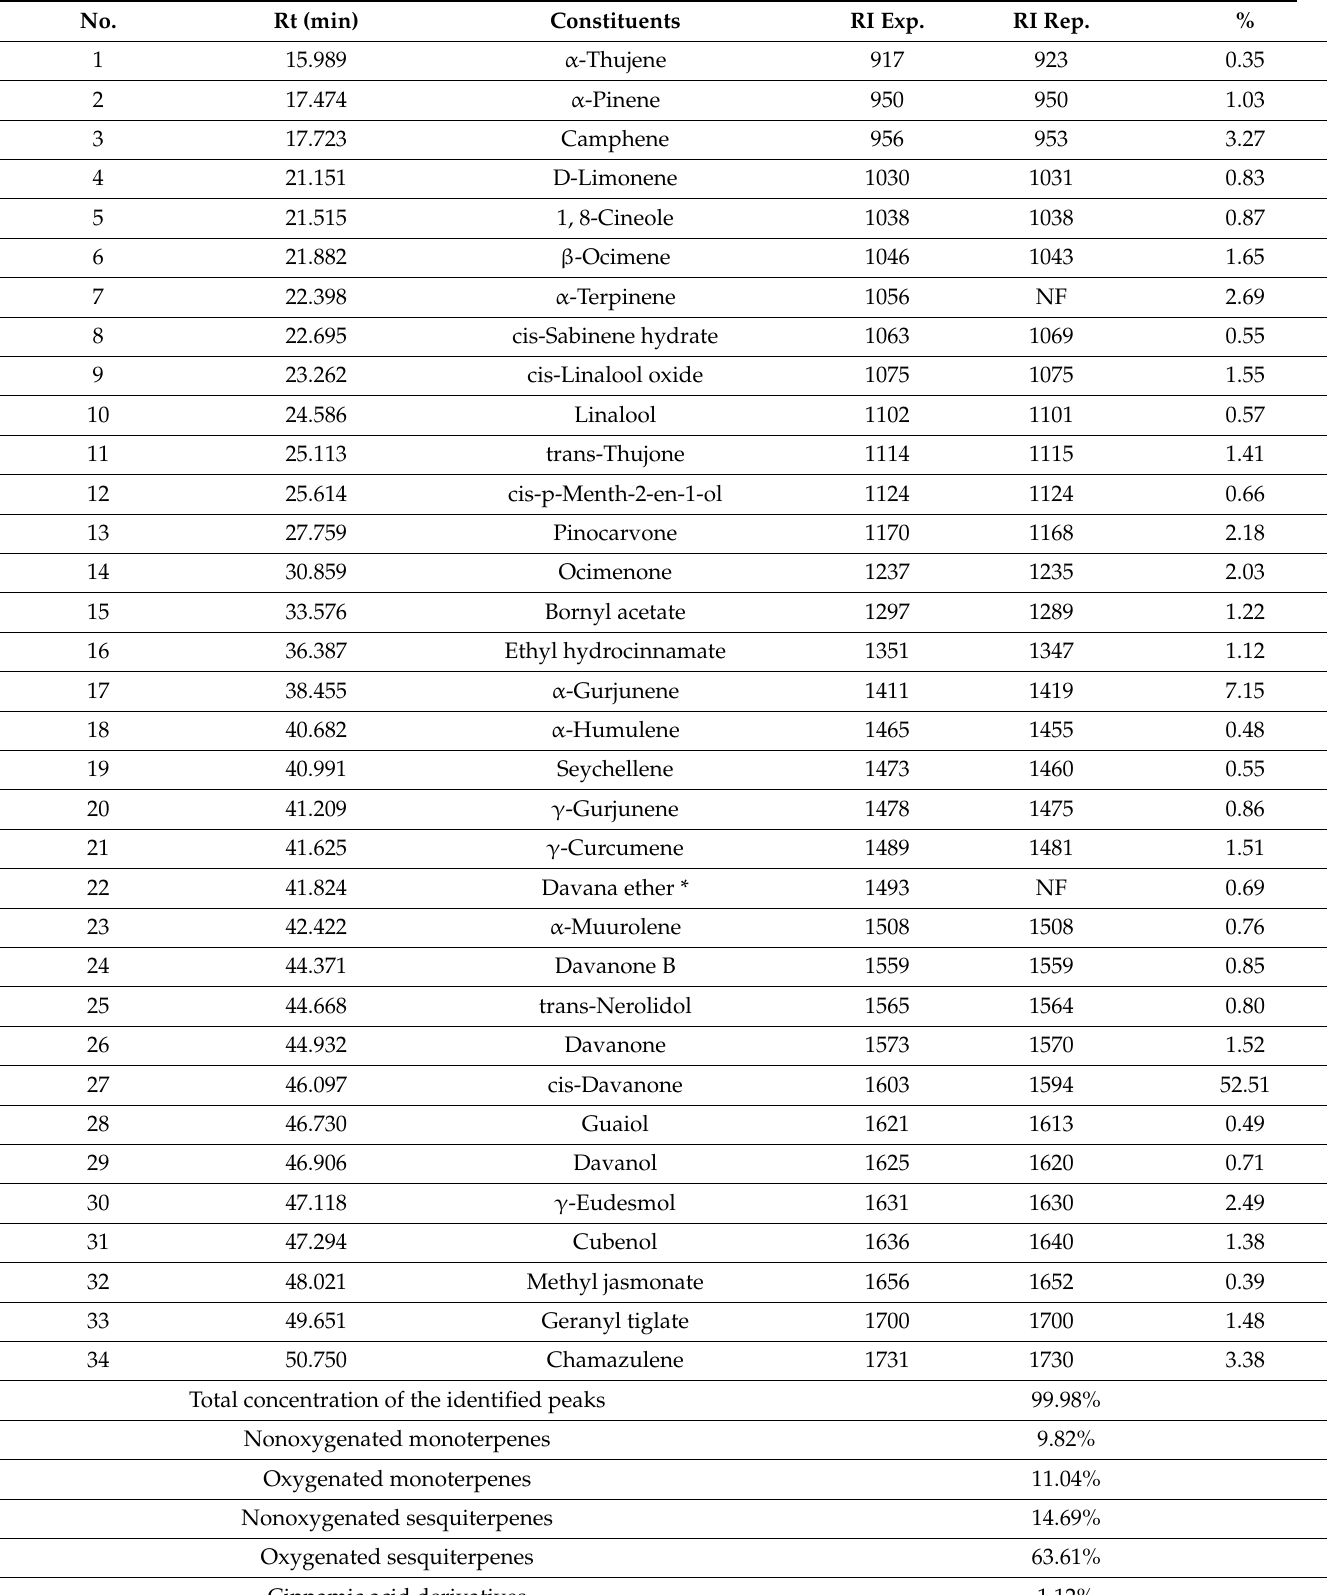
Table 2. Volatile oil constituents of A. absinthium growing in the central area of Saudi